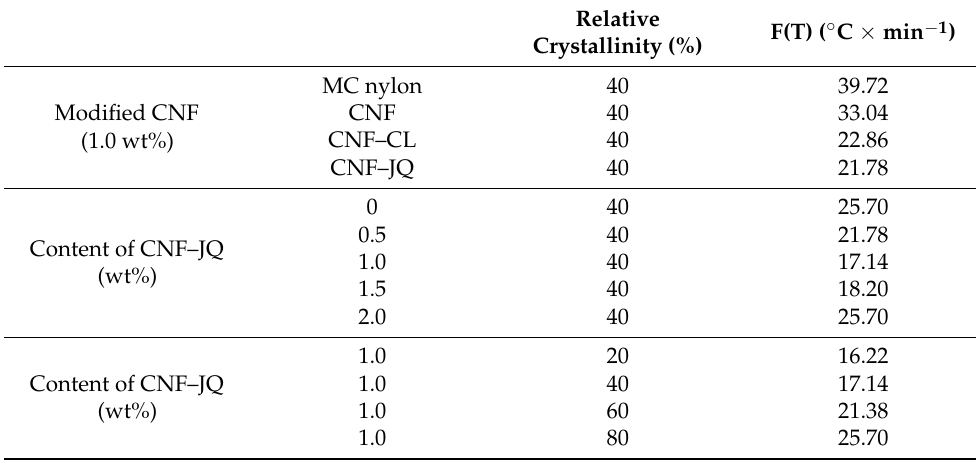
Table 4. Parameters of crystallization kinetic based on Mo’s